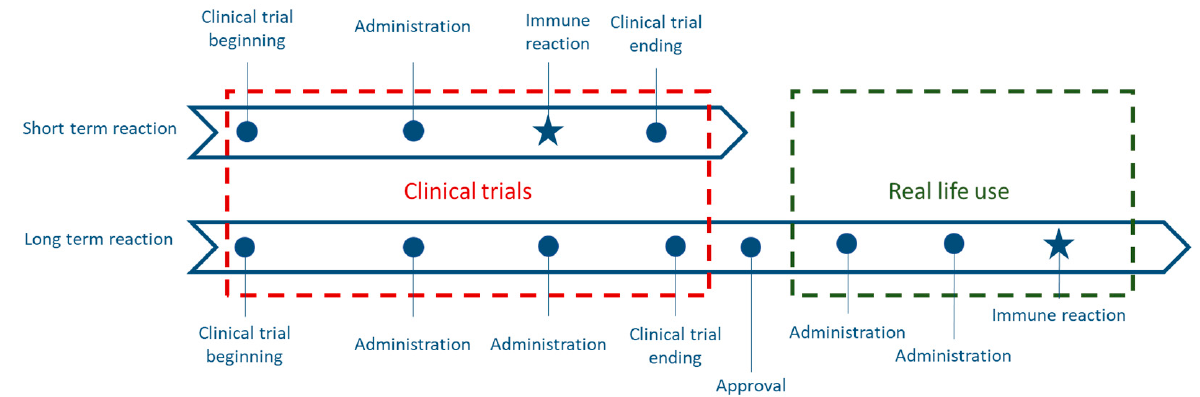
Figure 2. Limitations of clinical trials in terms of assessing long-term reactions.